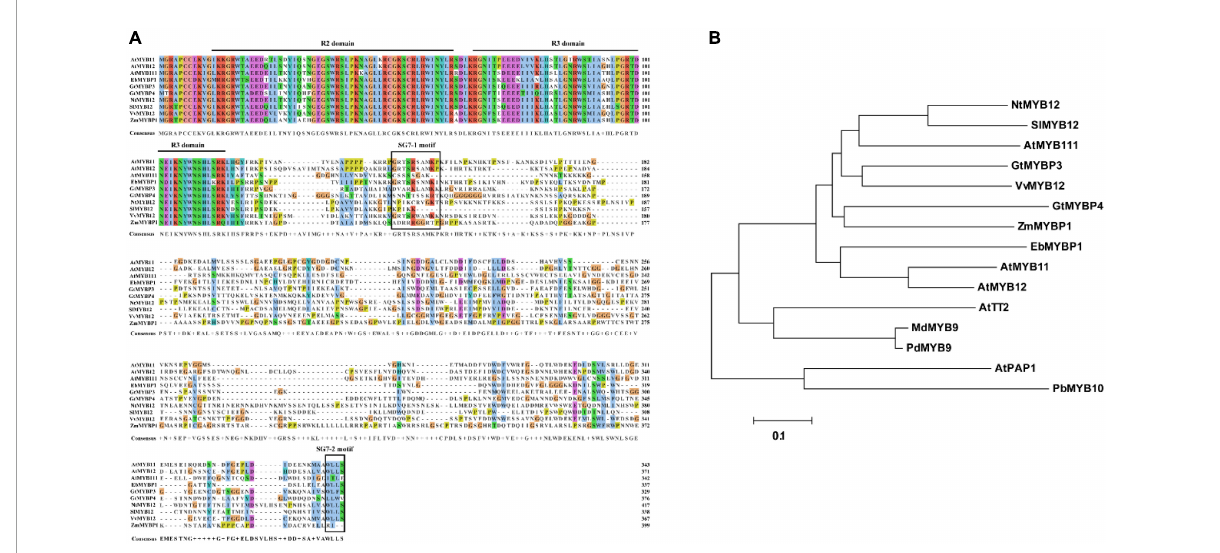
FIGURE1 Multiple sequence alignment and phylogenetic relationship of EbMYBP1. (A) Multiple sequence alignment of EbMYBP1. The R2/R3 repeats and SG7-1/SG7-2 are indicated in black frame. (B) Phylogenetic analysis of EbMYBP1 and other 14 homologs R2R3-MYB proteins. The tree was constructed using MEGA7 software based on the neighbor-jointing method.